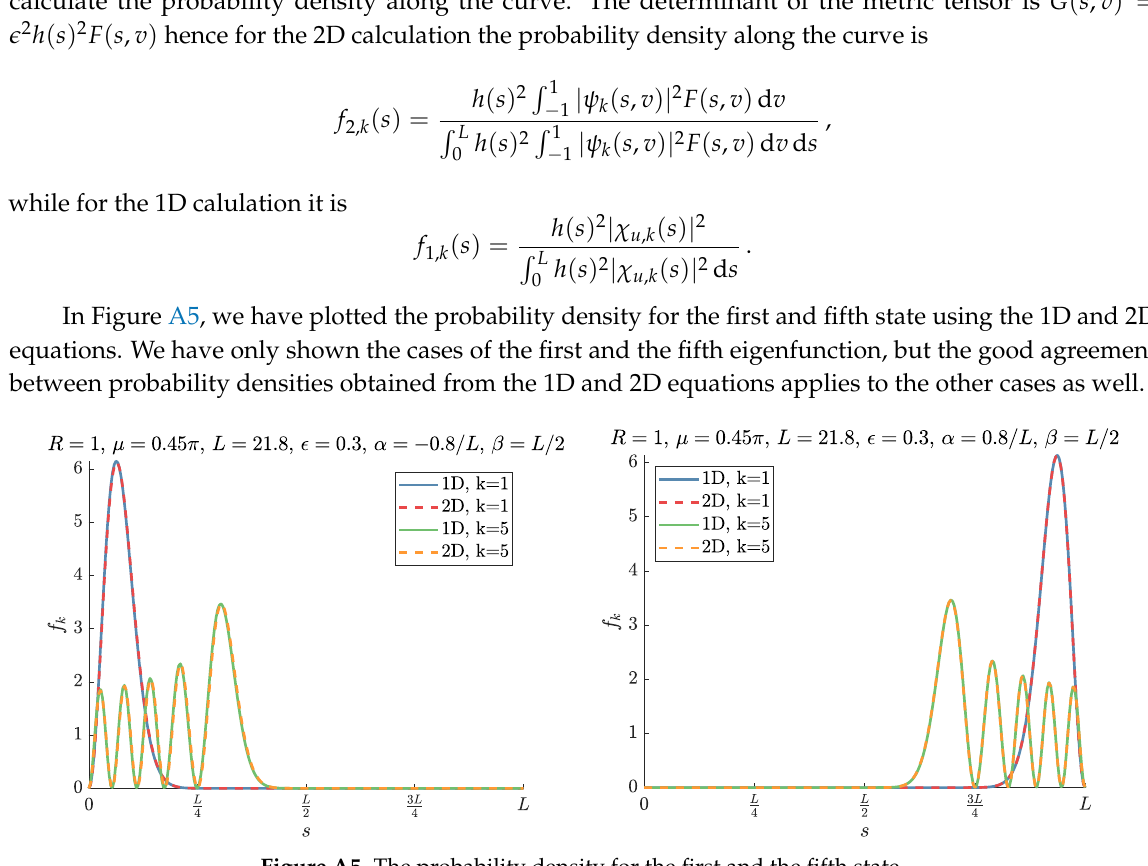
Figure A5. The probability density for the first and the fifth